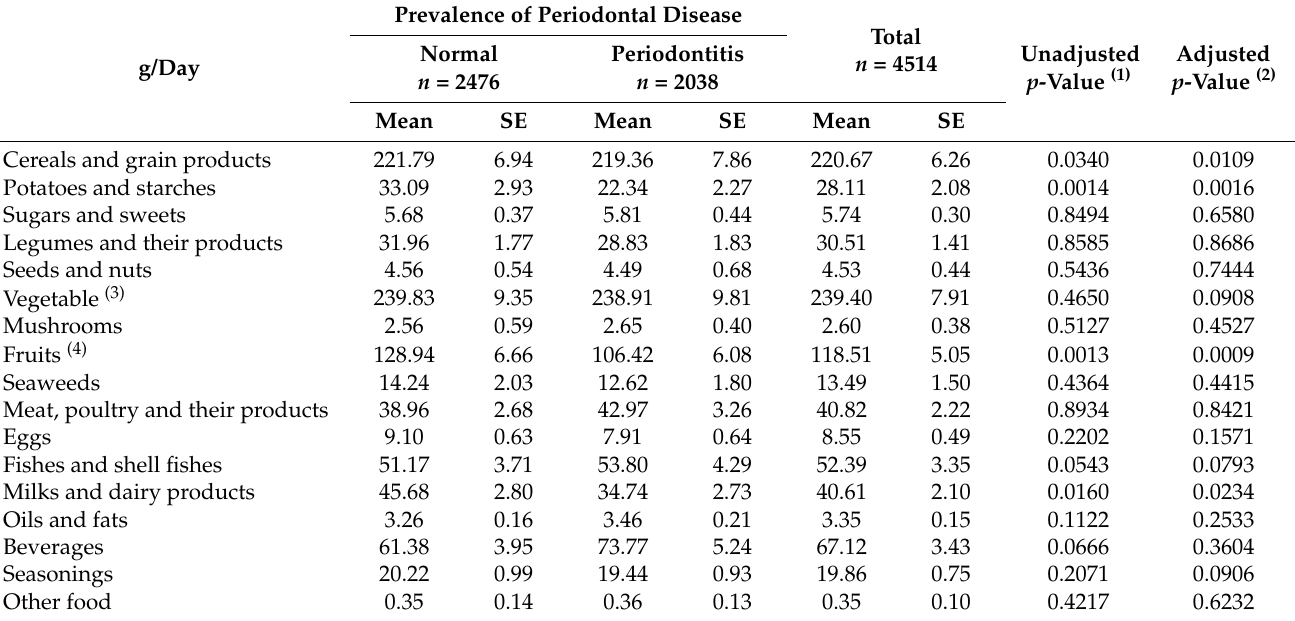
Table 5. Food intake according to prevalence of periodontitis in survey subjects.